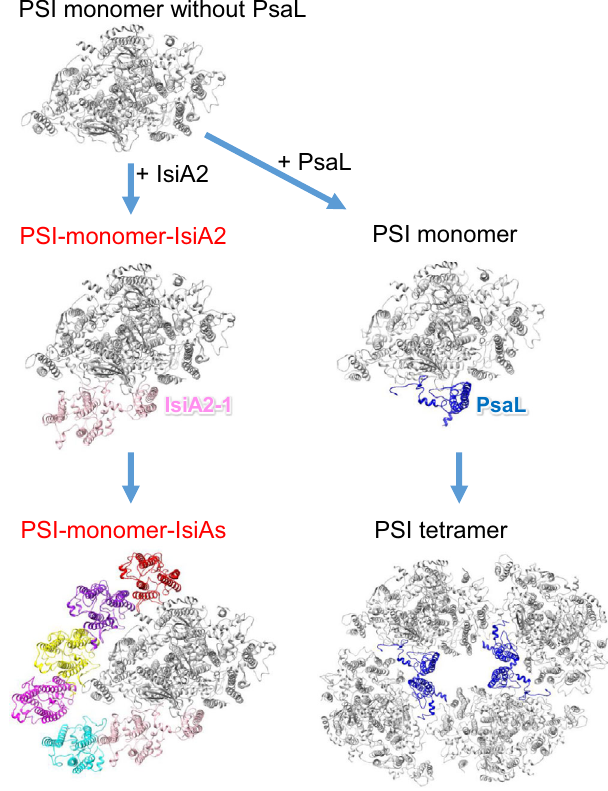
Fig. 8 | An assembly model proposed forthe Anabaena PSI-IsiAsupercomplex. The structures are viewed from the cytosolic side. The PSI monomer and tetramer structures are taken from 6JEO (PDB